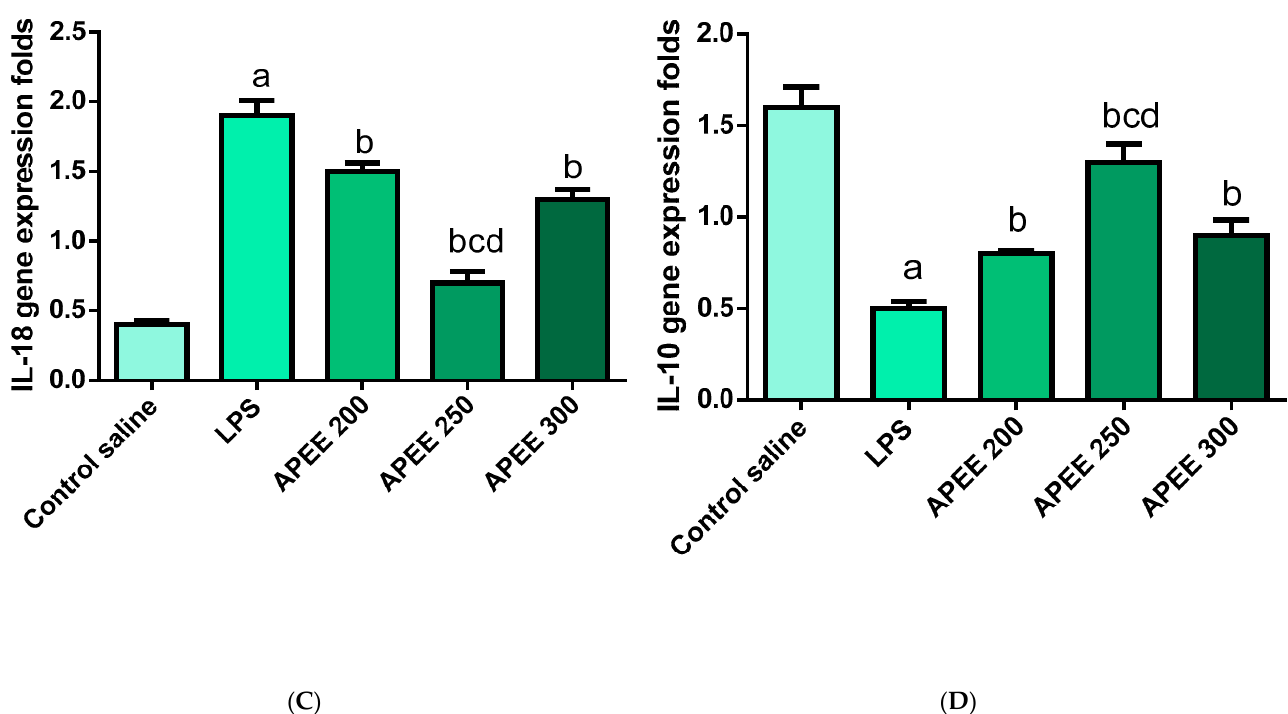
Figure 6. Impact of APEE pre-treatment on ( A ) Lung IL- 1β level, ( B ) Serum IL-6 level ( C ) IL-18 gene expression level, ( D ) IL-10 gene expression level. Acute lung injury was urged by I.P. injection of LPS (10 mg/kg). APEE 200, 250, and 300 were given I.P. 30 min before LPS injection. Results were expressed as mean ± SD ( n = 10/group) as the experiments were performed in three independent triplicates. Significant difference vs. a respective control, b respective LPS group, c respective APEE 200 group, d respective APEE 300 group each at p < 0.05.